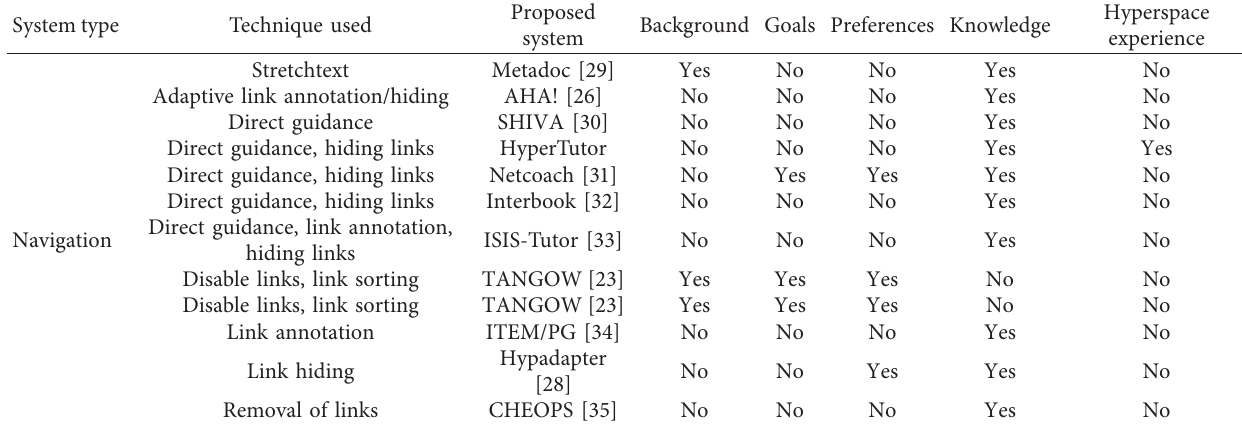
Table 2: Several adaptive navigation systems in the adaptive hypermedia domain.